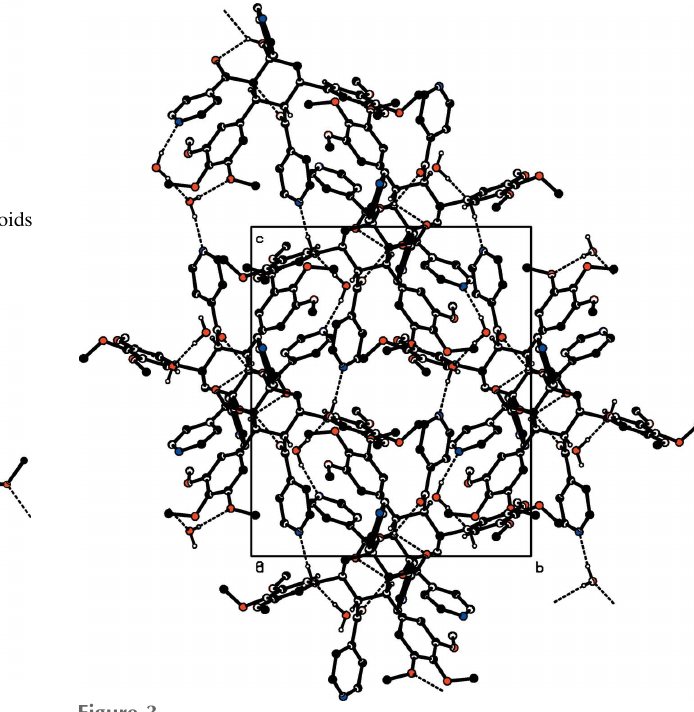
Figure 3 The crystal packing of the title compound, viewed along the a axis. Dashed lines indicate hydrogen bonds.